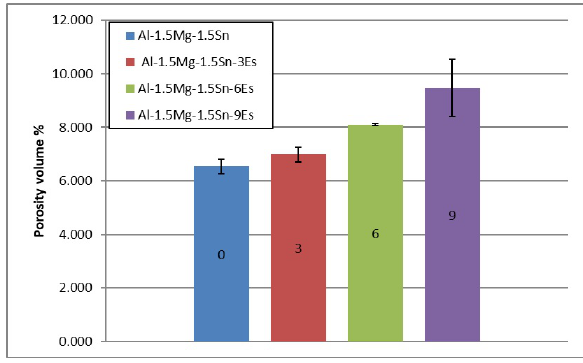
Figure 4: Porosity volume percentage of all fabricated composites.